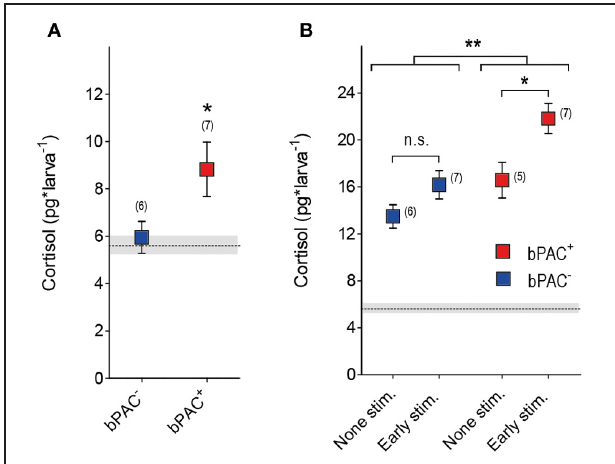
FIGURE 6 | Early blue-light stimulation causes long-term hypercortisolaemia in bPAC + larvae. (A) bPAC + (red squares) but not bPAC − larvae (blue squares) show increased basal cortisol levels after having being exposed to multiple light stimulations over 2 consecutive days (asterisks indicate statistical difference between groups at p < 0 . 05; light-power: 0.6mW ∗ cm − 2 ; sample size in parenthesis). (B) At 6dpf, bPAC + larvae (red squares) exposed to light stimulation at 4 and 5dpf (early stim.) respond to a squared pulse of blue-light with higher cortisol levels as compared to either none-exposed bPAC + (non-stim.) or exposed and non-exposed bPAC − larvae (asterisks indicate statistical differences between groups at p < 0 . 05 or p < 0 . 01; light-power: 0.6mW ∗ cm − 2 ; sample size in parenthesis). (A,B) Mean basal cortisol level ± S.E.M. of both bPAC + and bPAC − larvae shown as a dotted line and gray background,